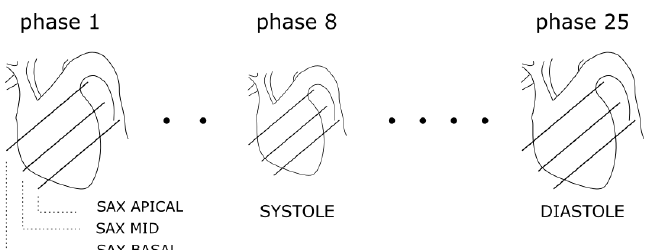
Figure 1. The illustration of how the short-axis images are created. The systole is the phase where the heart volume is the lowest, while in the diastole, it is the highest. A heart beat (cardiac cycle) is divided into 25 phases. In each phase, several slices are scanned. See the parallel lines. There are three major regions for the heart: basal, mid, apical.